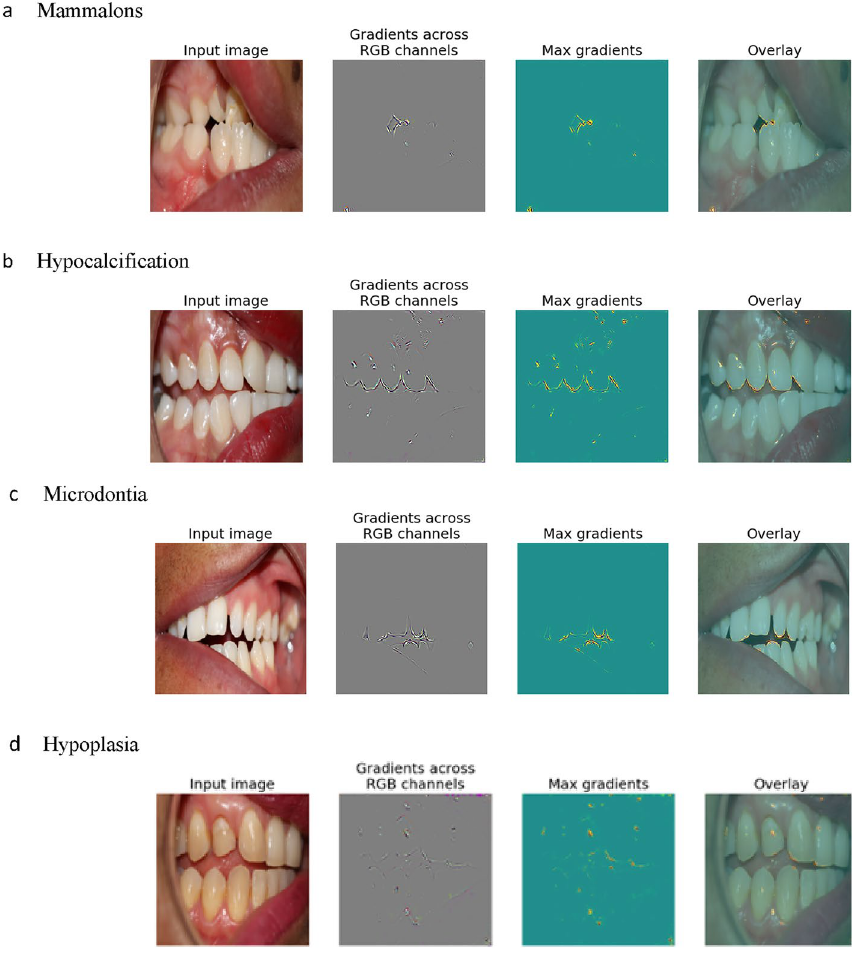
Figure 2. Saliency maps. Note : Overlay is the input image overlaid with the gradients. These are representative examples of anomalies depicting what the algorithm saw when making correct predictions of mammalons, hypocalcification, microdontia, and